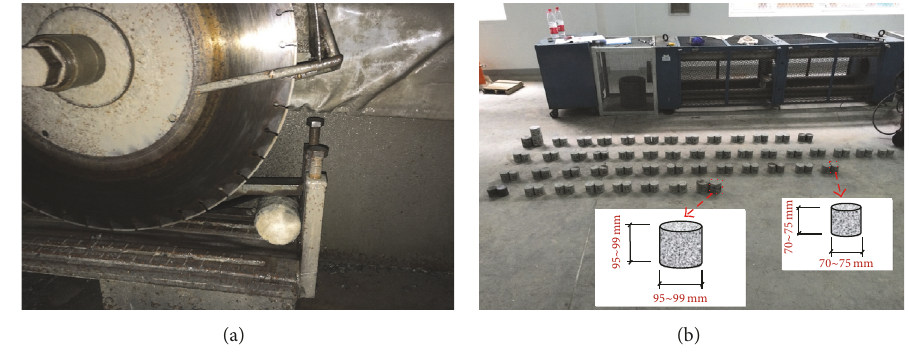
Figure 2: Incision progress and the incised cores.